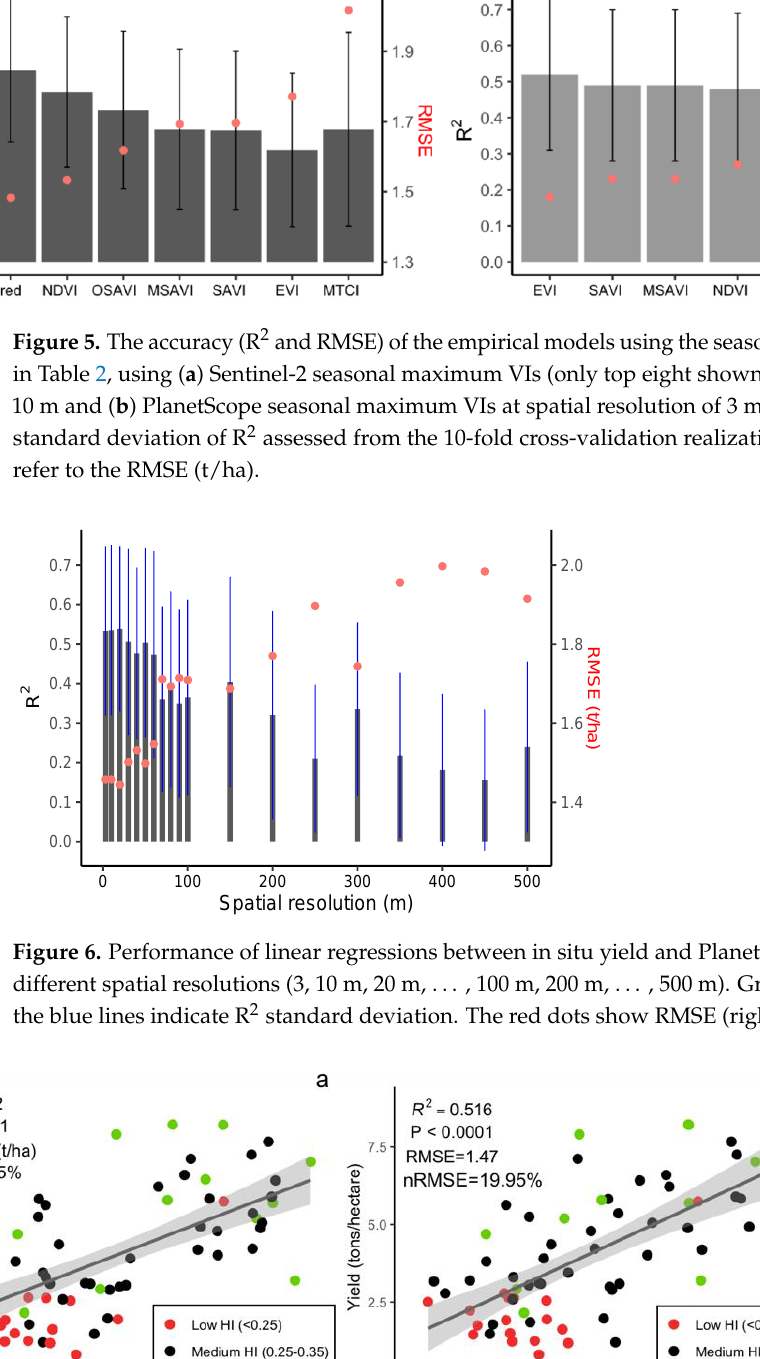
Figure 7. Linear correlation between in situ maize yield from 68 fields and ( a ) maximum PlanetScope EVI and ( b ) maximum CIgreen; ( c ) Correlation between in-situ LAI and SL2P-derived LAI; ( d ) linear regression between in situ yield and seasonal maximum SL2P-derived LAI. The colored dots indicate the harvest index (HI) category. 3.3. Factors Influencing Model Accuracy The evaluation of intercropping practices, field size, within-field variability, and harvest index against model residuals showed the mixed results. The intercropping practice reduced model accuracy, as the mean model residuals are lower in fields cultivated with pure maize fields (1 t/ha) compared to intercropped fields (1.3 t/ha) (Figure 8a). In addition, the harvest index was positively correlated to the model residuals (observed yield minus estimated yield) that were calibrated using Sentinel-2 CIgreen, demonstrating that the linear models tended to overestimate (/underestimate) yield for fields with a low (high) harvest index (Figures 7a and 8b). No clear correlation pattern was observed when considering the correlation between model residuals and the field size (Figure 8c). Finally, model residuals were not correlated to within-field variation (Figure 8d).